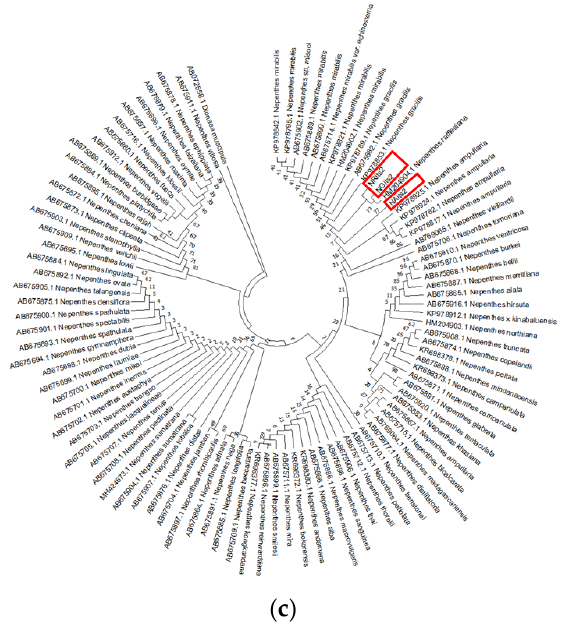
Figure 3. Neighbor joining tree of rbc L ( a ), ITS1 ( b ) and ITS2 ( c ) barcode primers depicting the phylogenetic analysis among N. ampullaria, N. gracilis, and N. rafflesiana (indicated in the red boxes).